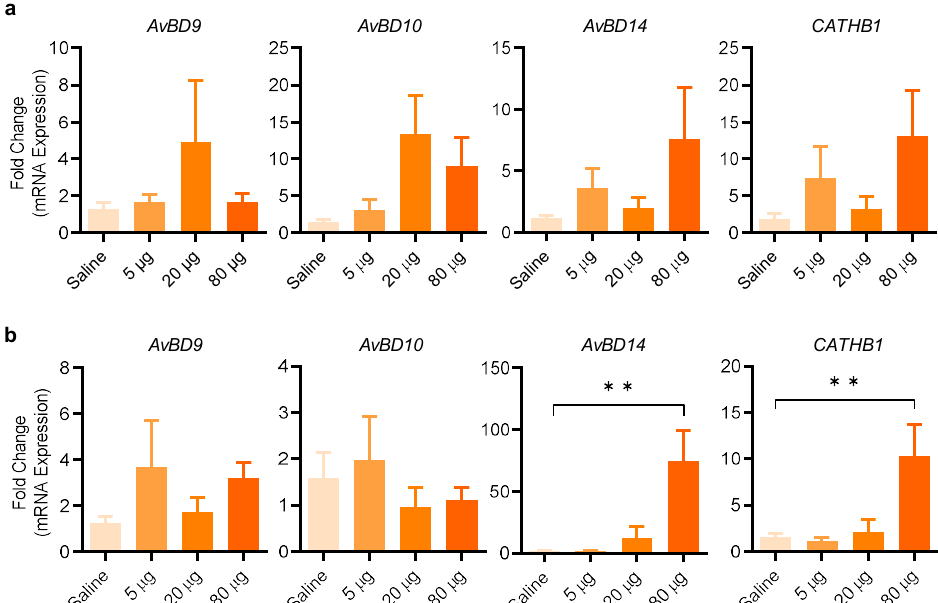
Figure 8. Entinostat-mediated induction of HDP gene expression in the crop and jejunum of chickens. Three-day-old broiler chickens were inoculated with or without an indicated amount of entinostat in 0.5 mL saline by oral gavage every 12 h for 2 days, with 12 animals per treatment. A segment of the crop ( a ) and jejunum ( b ) was collected from each animal for RT-qPCR analysis of HDP mRNA expression (n = 12). ** p < 0.01 (by one-way ANOVA and post-hoc Dunnett’s multiple comparisons test).